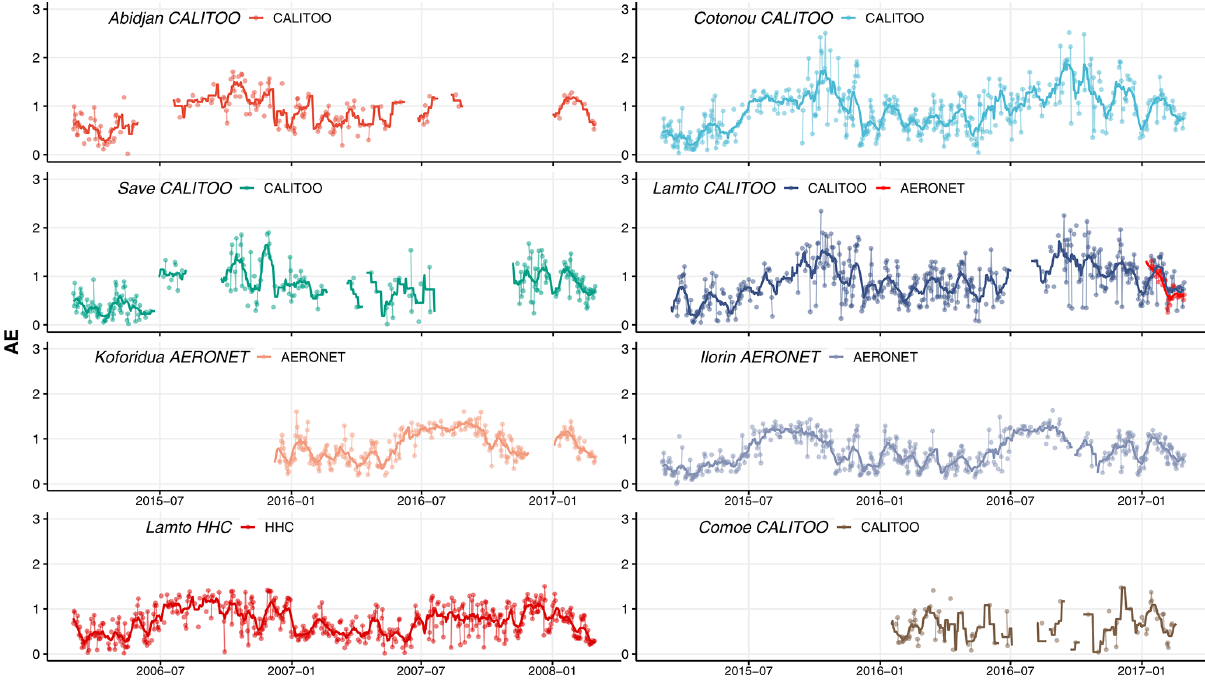
Figure 4. Same as Fig. 3 for the visible Ångström